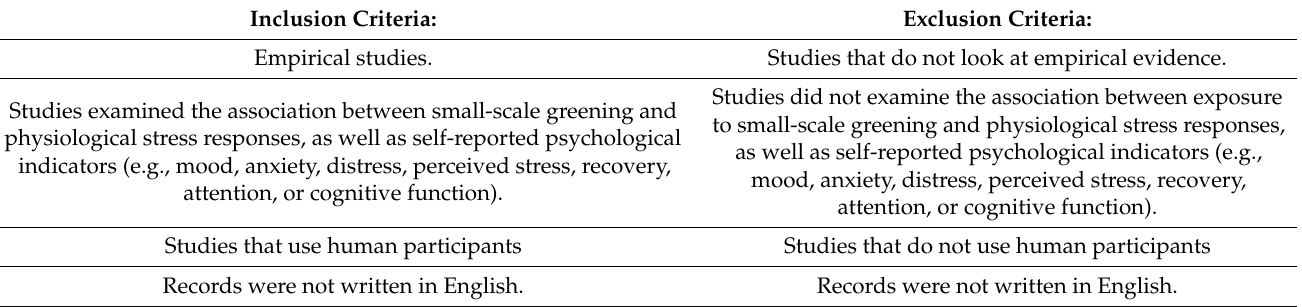
Table 1. Inclusion and exclusion